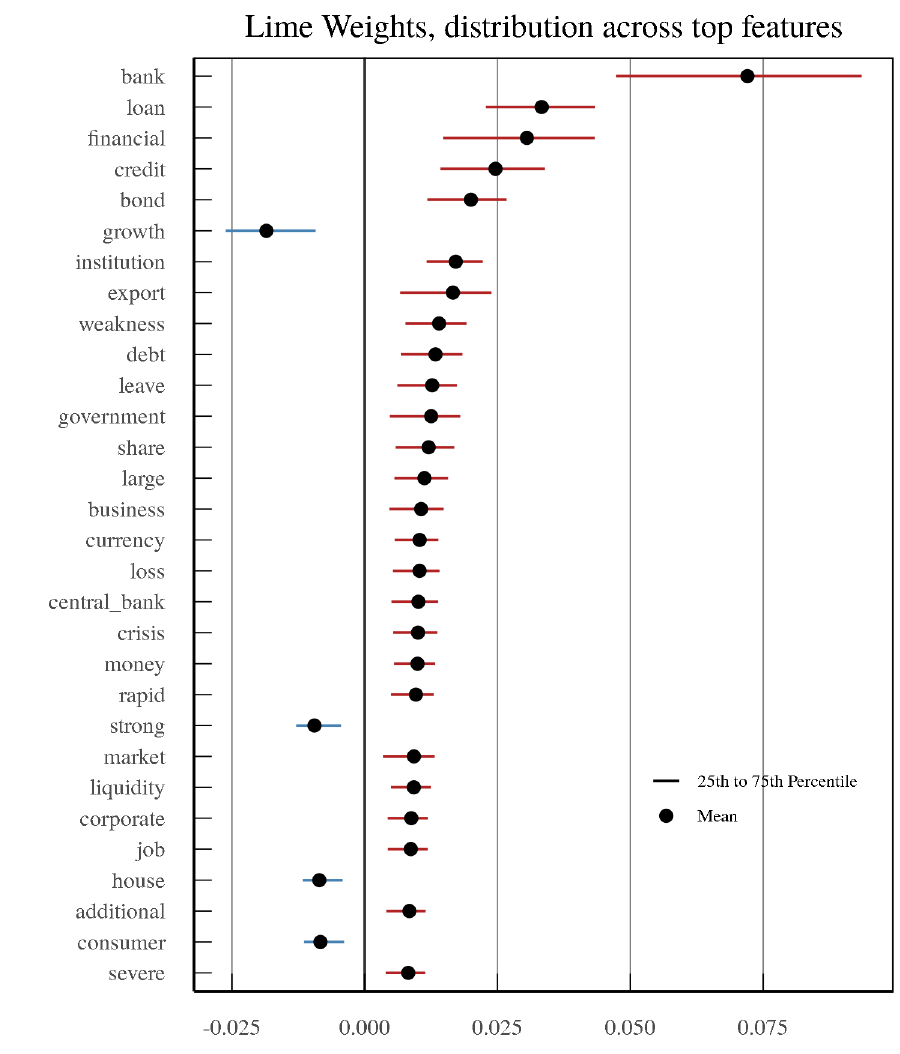
Figure 10. Top 30 Average Feature Weights for Minor Crises on OECD Text . Note: Local Inter- pretable Model-agnostic Explanations (LIME) provides a method of unveiling the black-box nature of machine learning algorithms by running a model with and without features (terms). This figure shows how much, on average, the top 30 terms according to LIME feature weights contribute to the model probability outputs of crisis. For example, the mention of “bank” in the OECD Economic Outlook text contributes mostly 0.5 to 1 percentage point to the model probability output of an observation being in a minor or more severe crisis. In contrast, words such as “strong” are associated with a decrease in this model probability output on average. These results are based on the SVM Radial model trained on OECD text from 1981–2004 predicting Romer 5+